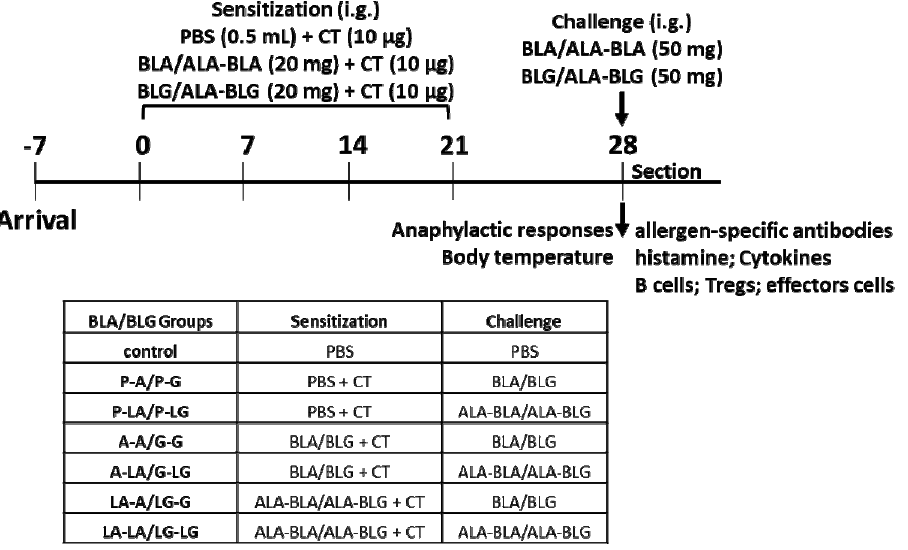
Figure 1. Sensitization and challenge experiments. Treatment scheme: mice were sensitized weekly by i.g. with BLA, ALA–BLA, BLG, or ALA–BLG in PBS using CT as an adjuvant and challenged